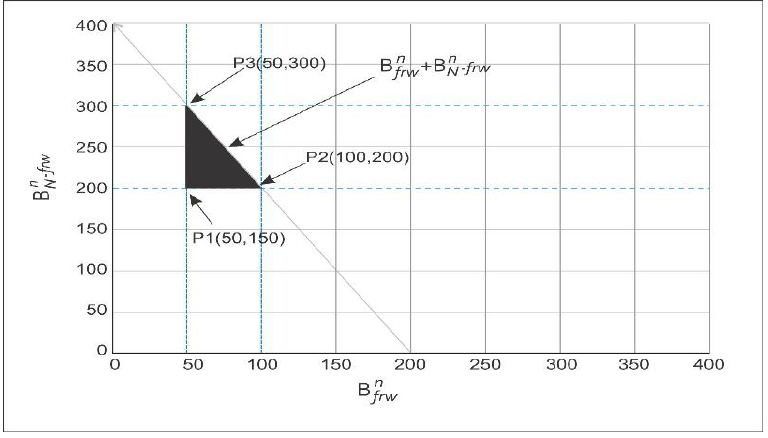
Figure 10. Possible feasible region of throughput maximization.